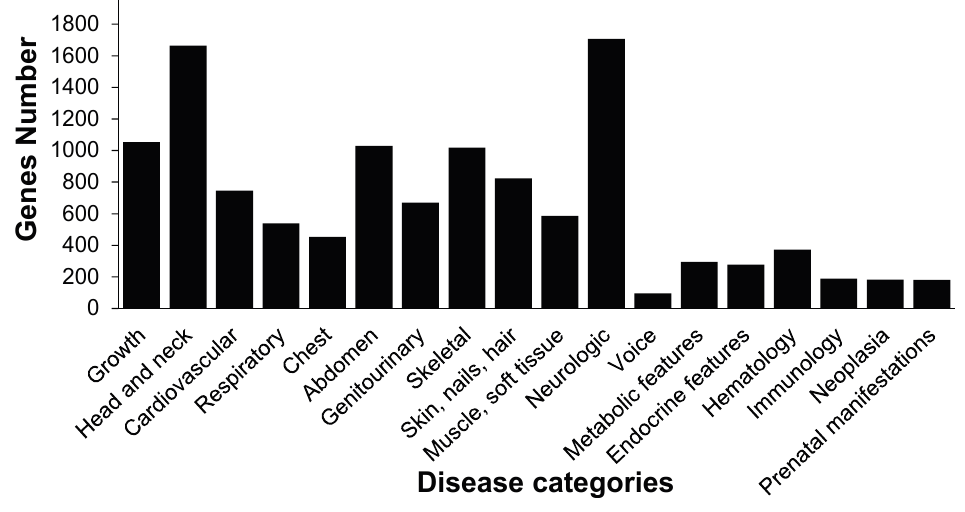
Figure 2. Gene ontology (GO) term classifications of silkworm orthologs of human